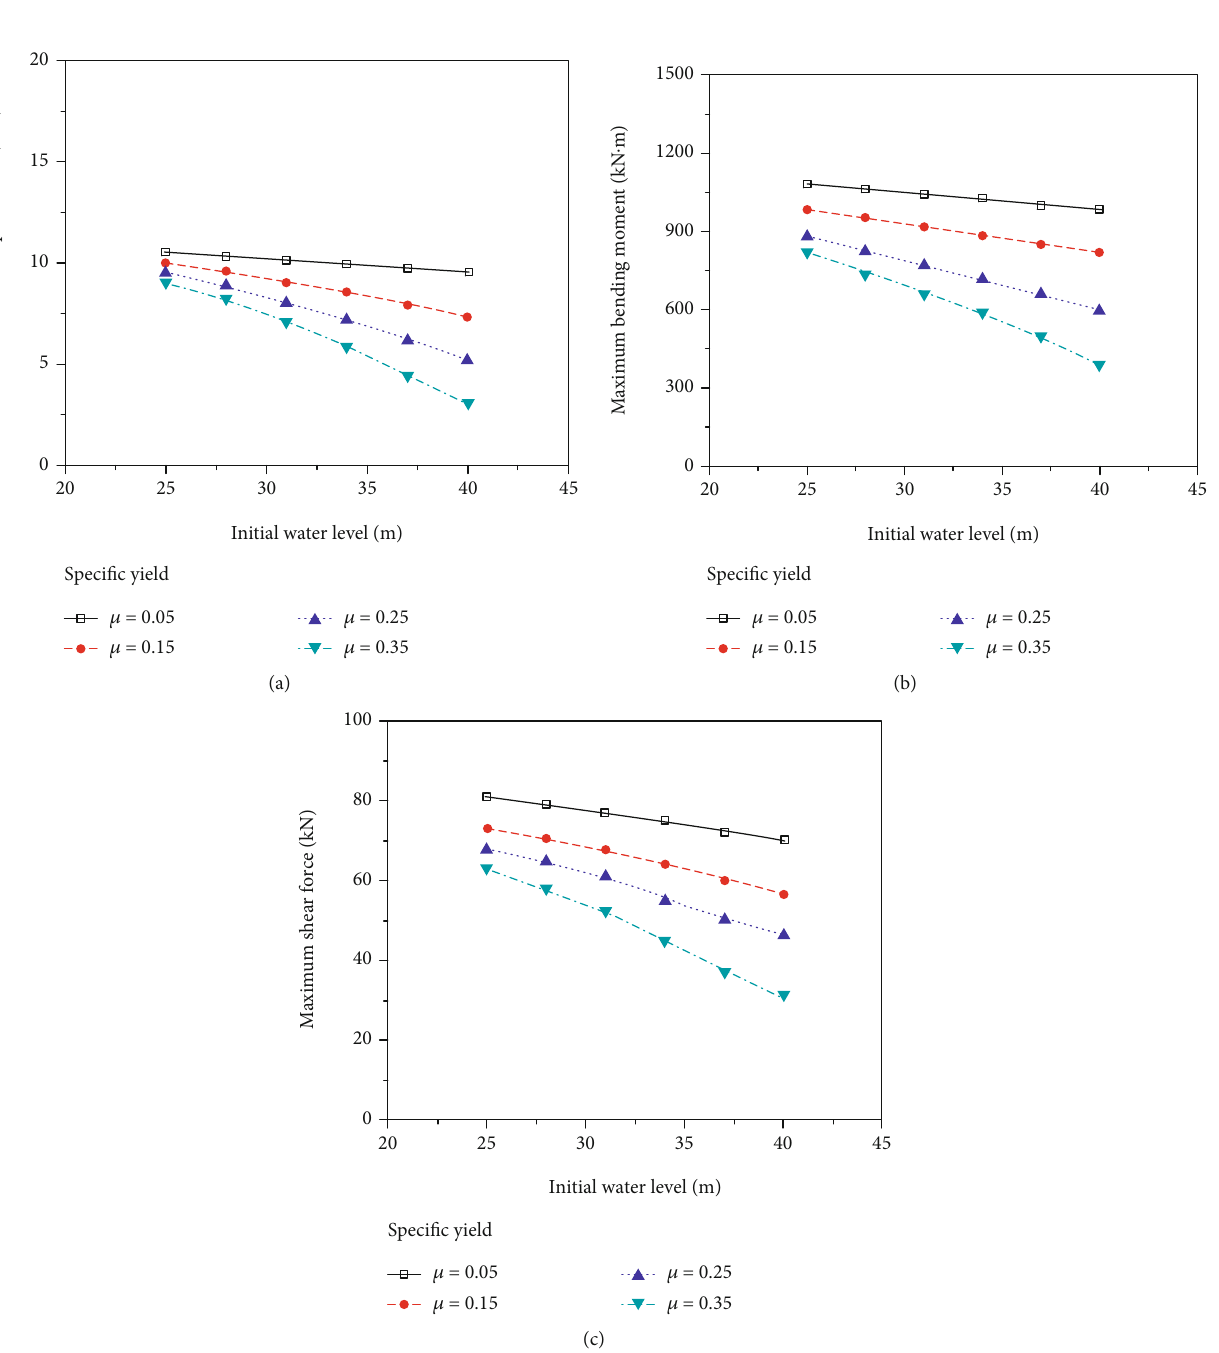
Figure 13: E ff ects of the initial water level on (a) tunnel maximum vertical displacement; (b) tunnel maximum bending moment; (c) tunnel maximum shear